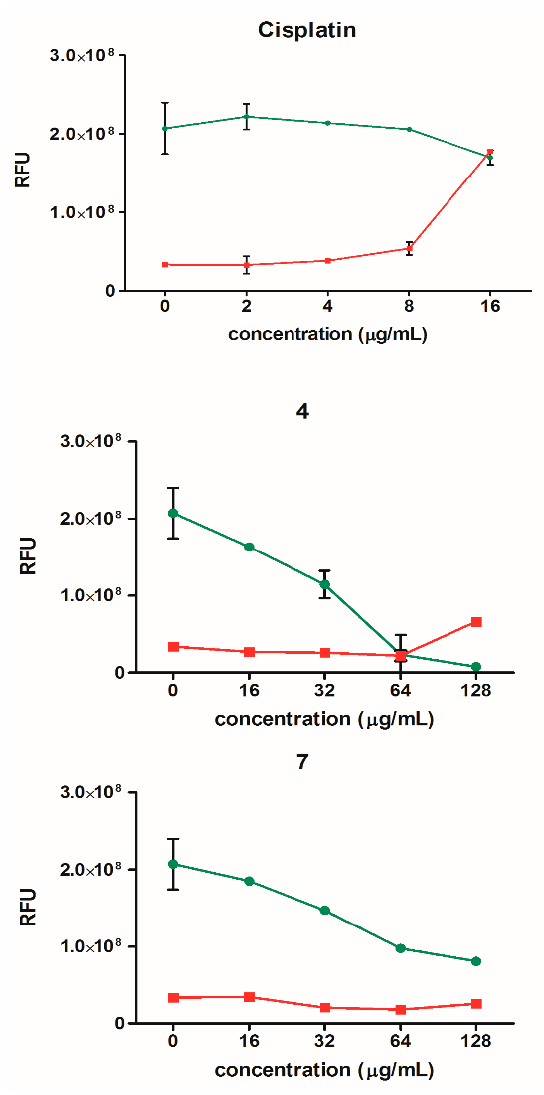
Figure 8. Cell viability ( green ) and cytotoxicity ( red ) of HeLa cells after treatment with compounds 4 and 7 (16–128 µg/mL) and cisplatin (2–16 µg/mL). The results are presented as mean ± SEM from two independent experiments. RFU: relative fluorescence units.